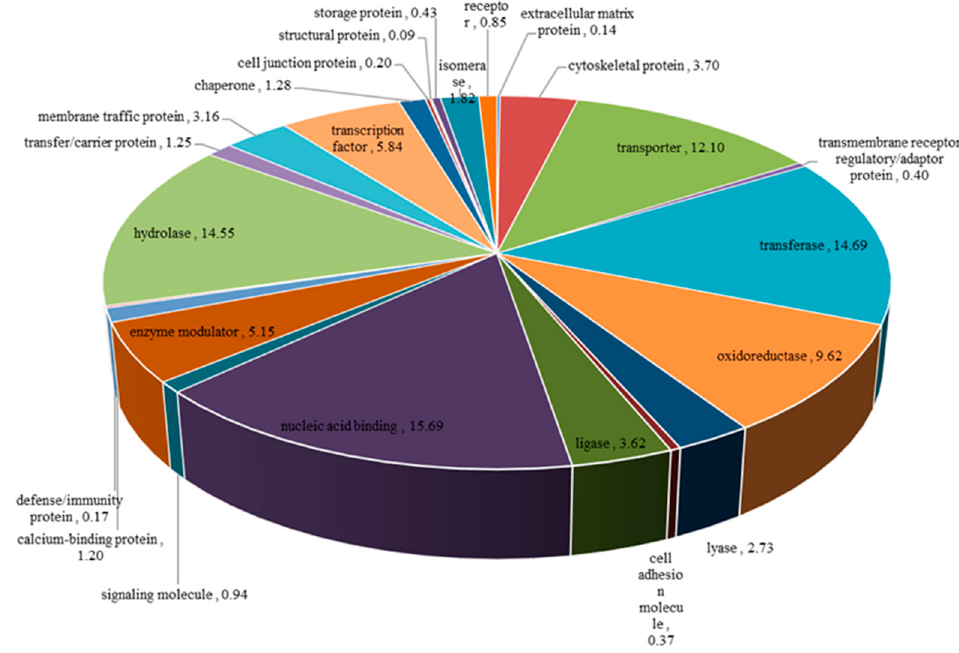
Figure 3. Average abundance of protein classes in the different tissues of Cosmos caudatus transcriptome. The area under each pie represents the percentage (%) value of an actual number of transcripts.